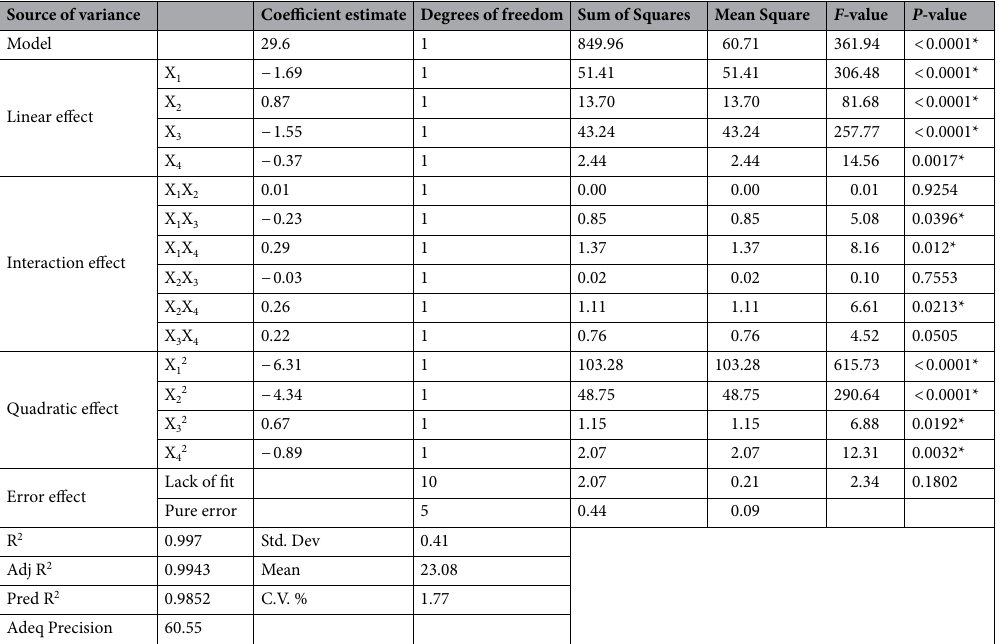
Table 6. Analysis of variance for endoglucanase production by Bacillus subtilis strain Fatma/1 as affected by CMC, yeast extract, peptone and FeSO 4 concentrations. *Significant values, F : Fishers’s function, P : Level of significance, C.V: Coefficient of